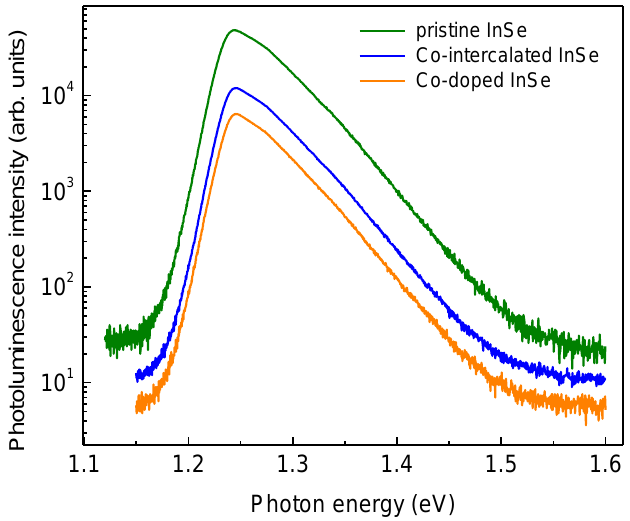
Figure 2. Photoluminescence spectra of bulk InSe samples measured with the excitation laser wavelength of 532 nm ( p = 100 mW) at T = 300 K for: as-grown pristine, Co-intercalated and Co-doped InSe crystals.